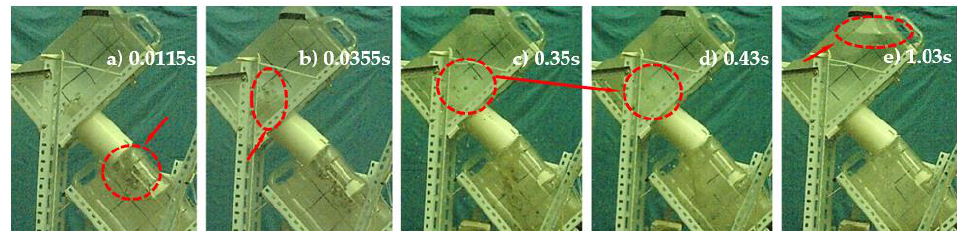
Figure 8. Process for experimental case 4 (β = 40°, h = 305